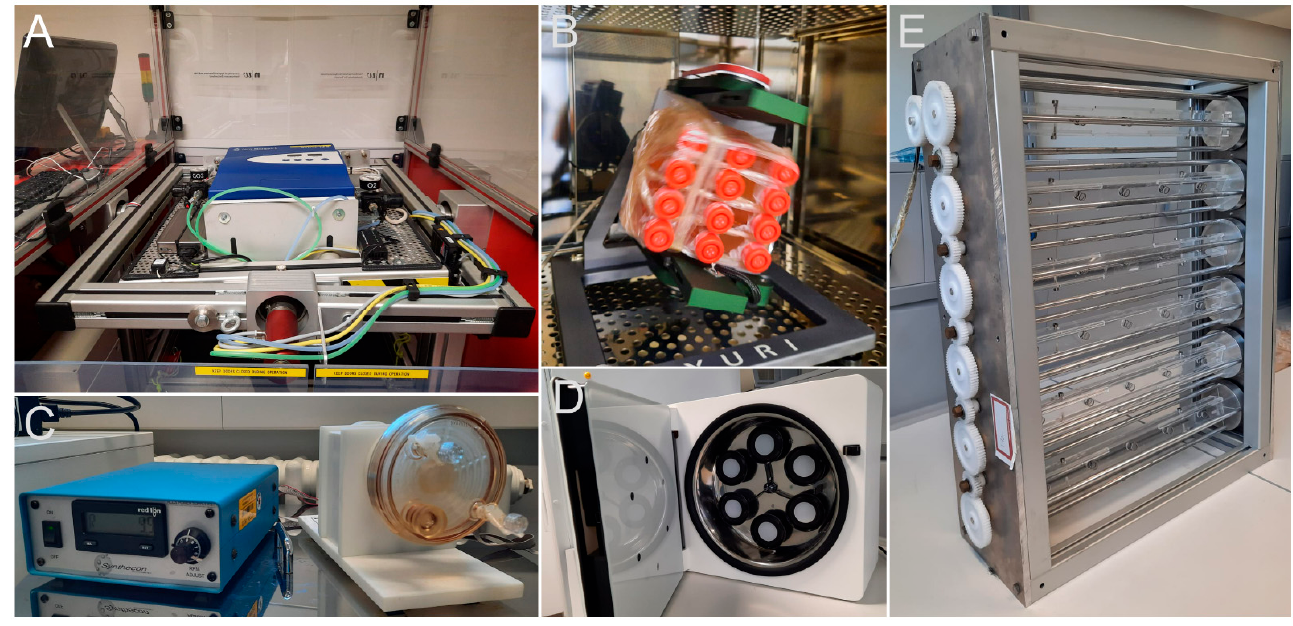
Figure 3. Ground-based s- µ g facilities: ( A ) The Random Positioning Incubator (RPI) developed by the ‘ Fachhochschule Nordwestschweiz ’ (FHNW) and the ‘ Eidgenössische Technische Hochschule ’ (ETH) Zurich, Switzerland, ( B ) a desk-top random positioning machine housed in an incubator purchased from Yuri GmbH Meckenbeuren, Germany, ( C ) the NASA-developed Rotating Wall Vessel, ( D ) the ClinoStar CO 2 incubator with integrated clinostat (CelVivo ApS, Odense, Denmark), and ( E ) a 2D fast-rotating clinostat for adherent cells in slide flasks (developed by the German Space Agency, Cologne,